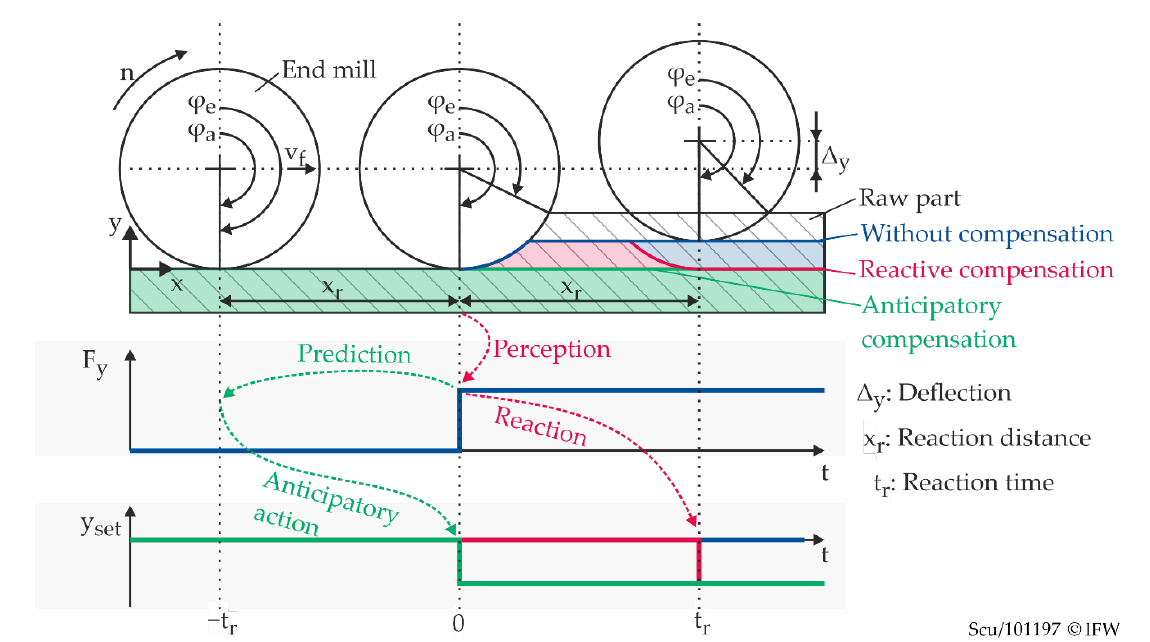
Figure 5. Comparison of reactive and anticipatory deflection compensation over time in the event of an abrupt change in engagement conditions.